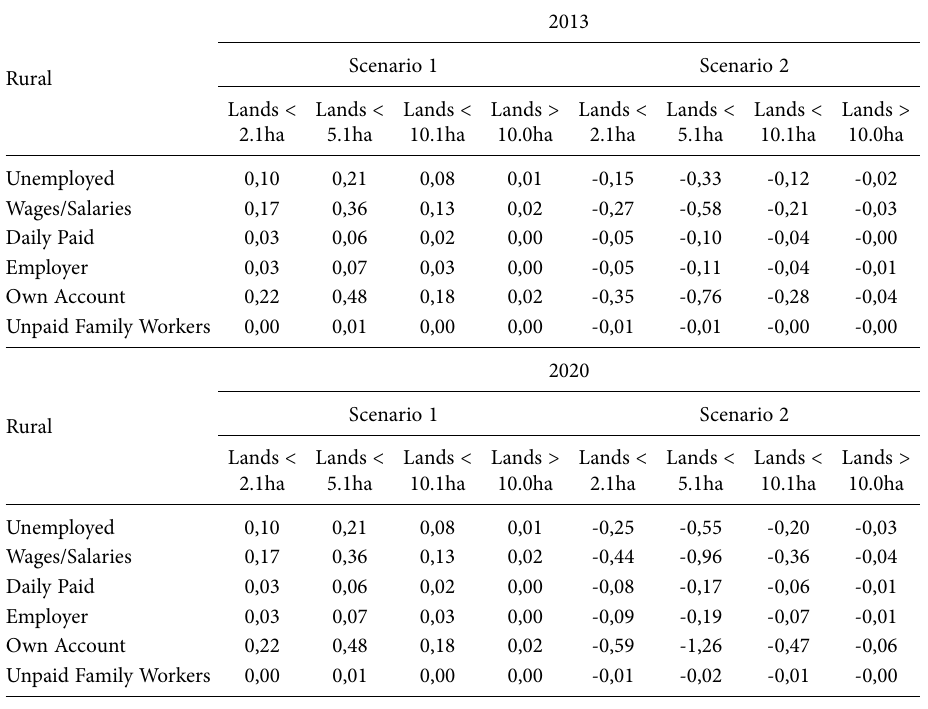
Table A3. Household income effect sourced by agricultural lands-Open loop effect (million TL).